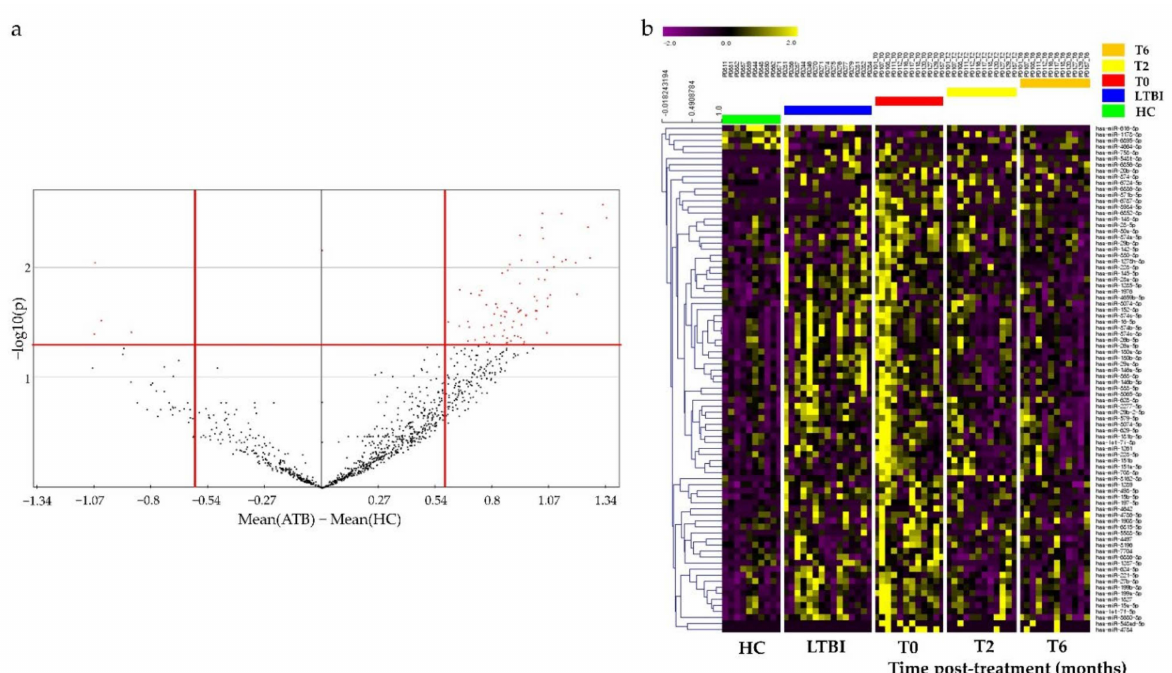
Figure 1. Volcano plot and heat map of differentially expressed miRNAs in whole blood of pa- tients with active tuberculosis (ATB), latent tuberculosis infection (LTBI) and healthy controls (HCs). ( a ) Volcano plot of miRNAs between patients with ATB and HCs. Cut-off points for the p value (<0.05; − log − 0.5) are indicated by red lines. ( b ) Heat map of the 10 (0.05) = 1.30) or mean difference (>0.5 or < 84 significantly differentially expressed miRNAs for patients with ATB after two (T2) and six months of treatment (T6), LTBI, and HCs (Pearson correlation; p < 0.05 by hierarchical clustering analysis). Yellow dots represent upregulated miRNAs, and blue dots represent downregulated miRNAs.